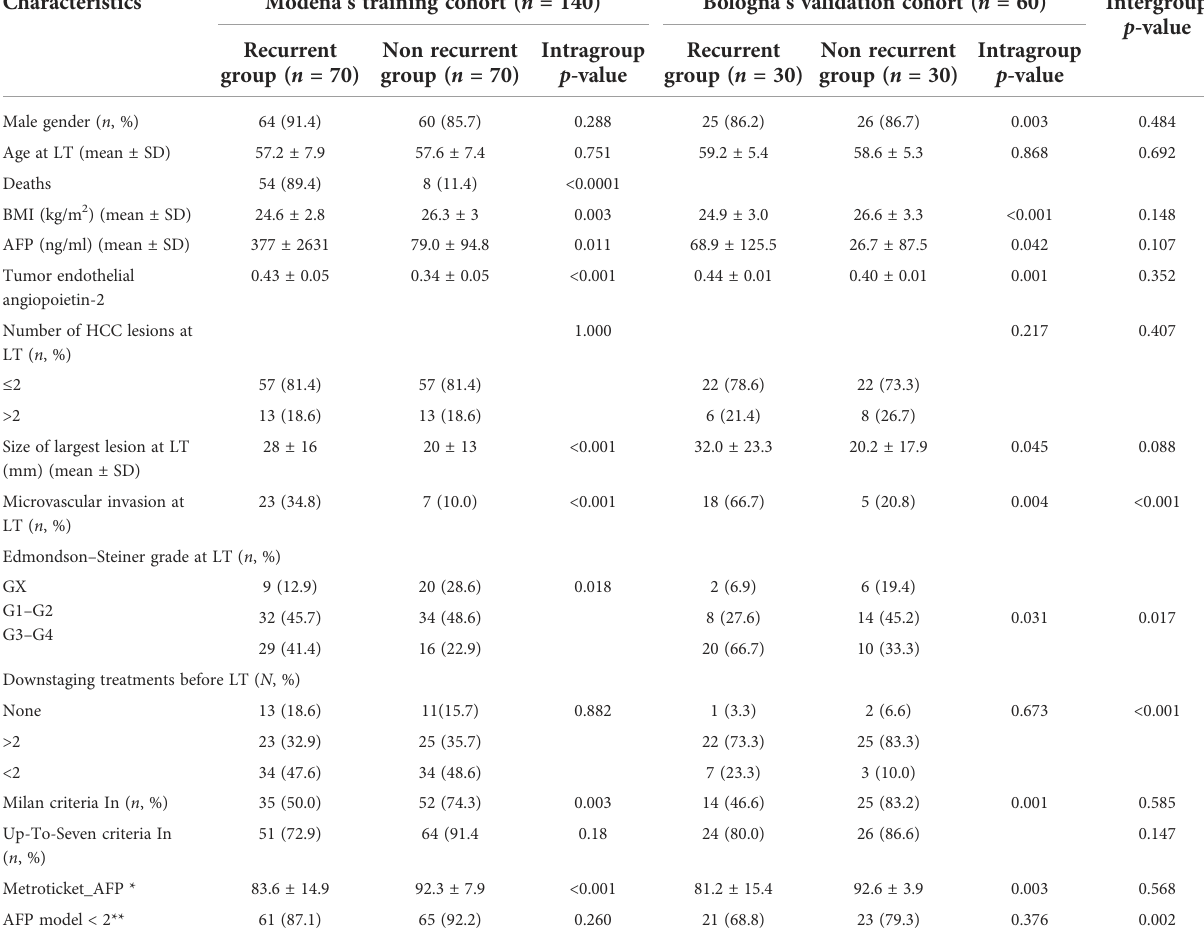
TABLE 2 Demographic, clinical, pathological, and histopathological features of training (Liver Transplant Centre of Modena) ( n = 140) and validation (Liver Transplant Centre of Bologna) ( n = 60) cohorts at the time of liver transplant for hepatocellular carcinoma (HCC).